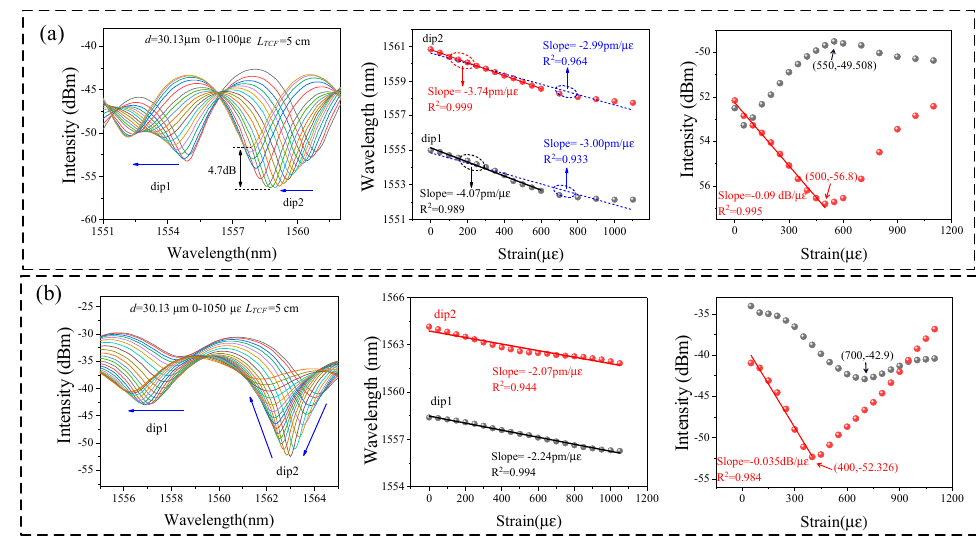
Figure 8. Transmission spectra, the wavelength and intensity sensitivities of t -TCF ( a ) before and ( b ) after packaging when d = 30.13 µm.